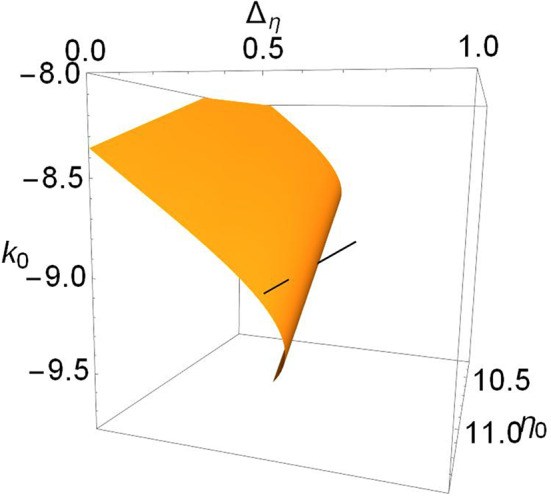
Magnified view of the Hopf surface shown in the lower middle panel of Figure 4, for Δk = 1.3, showing two intersections.